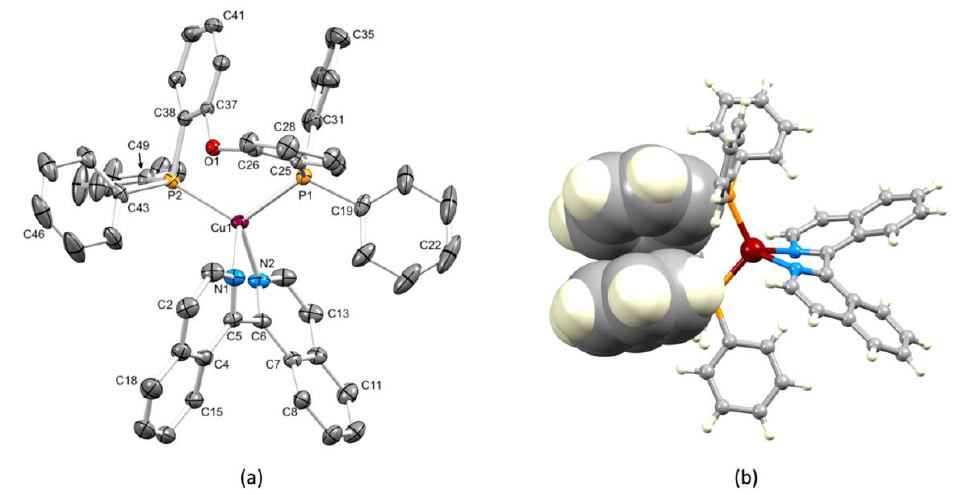
Figure 1. ( a ) An ORTEP-type plot of the [Cu(POP)(biq)] + cation in [Cu(POP)(biq)][PF 6 ] . 0.5Et 2 O with ellipsoids plotted at 40% probability level and H atoms omitted for clarity. Selected bond